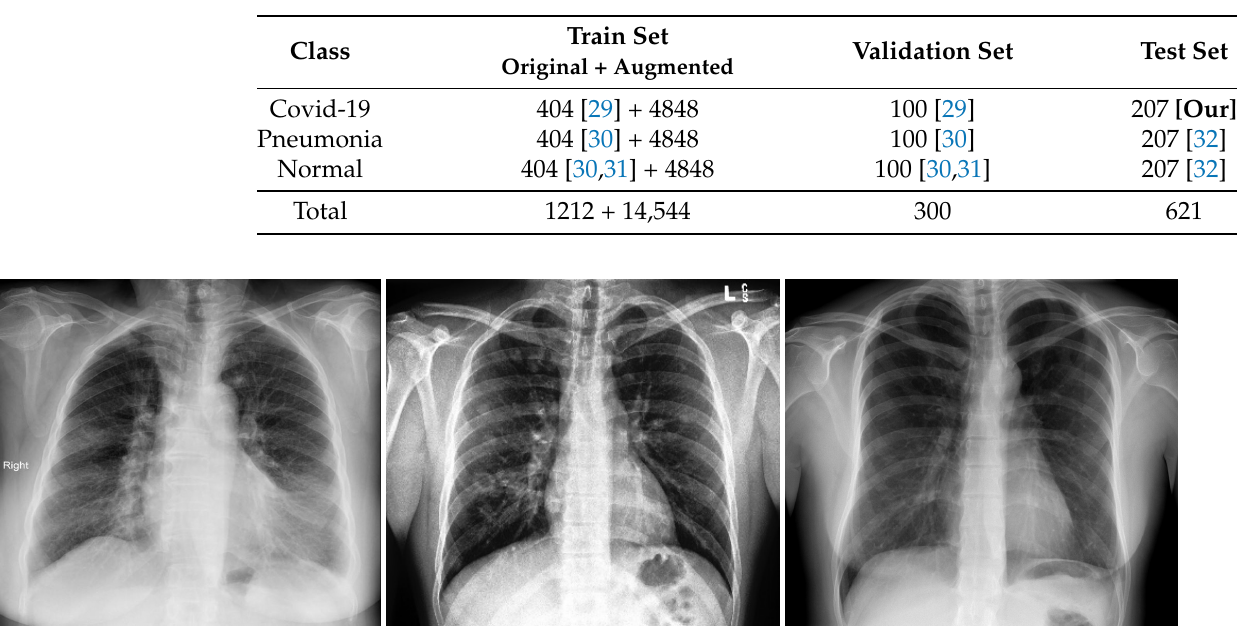
Table 2. Three-class COVID-19 database sources and statistics.